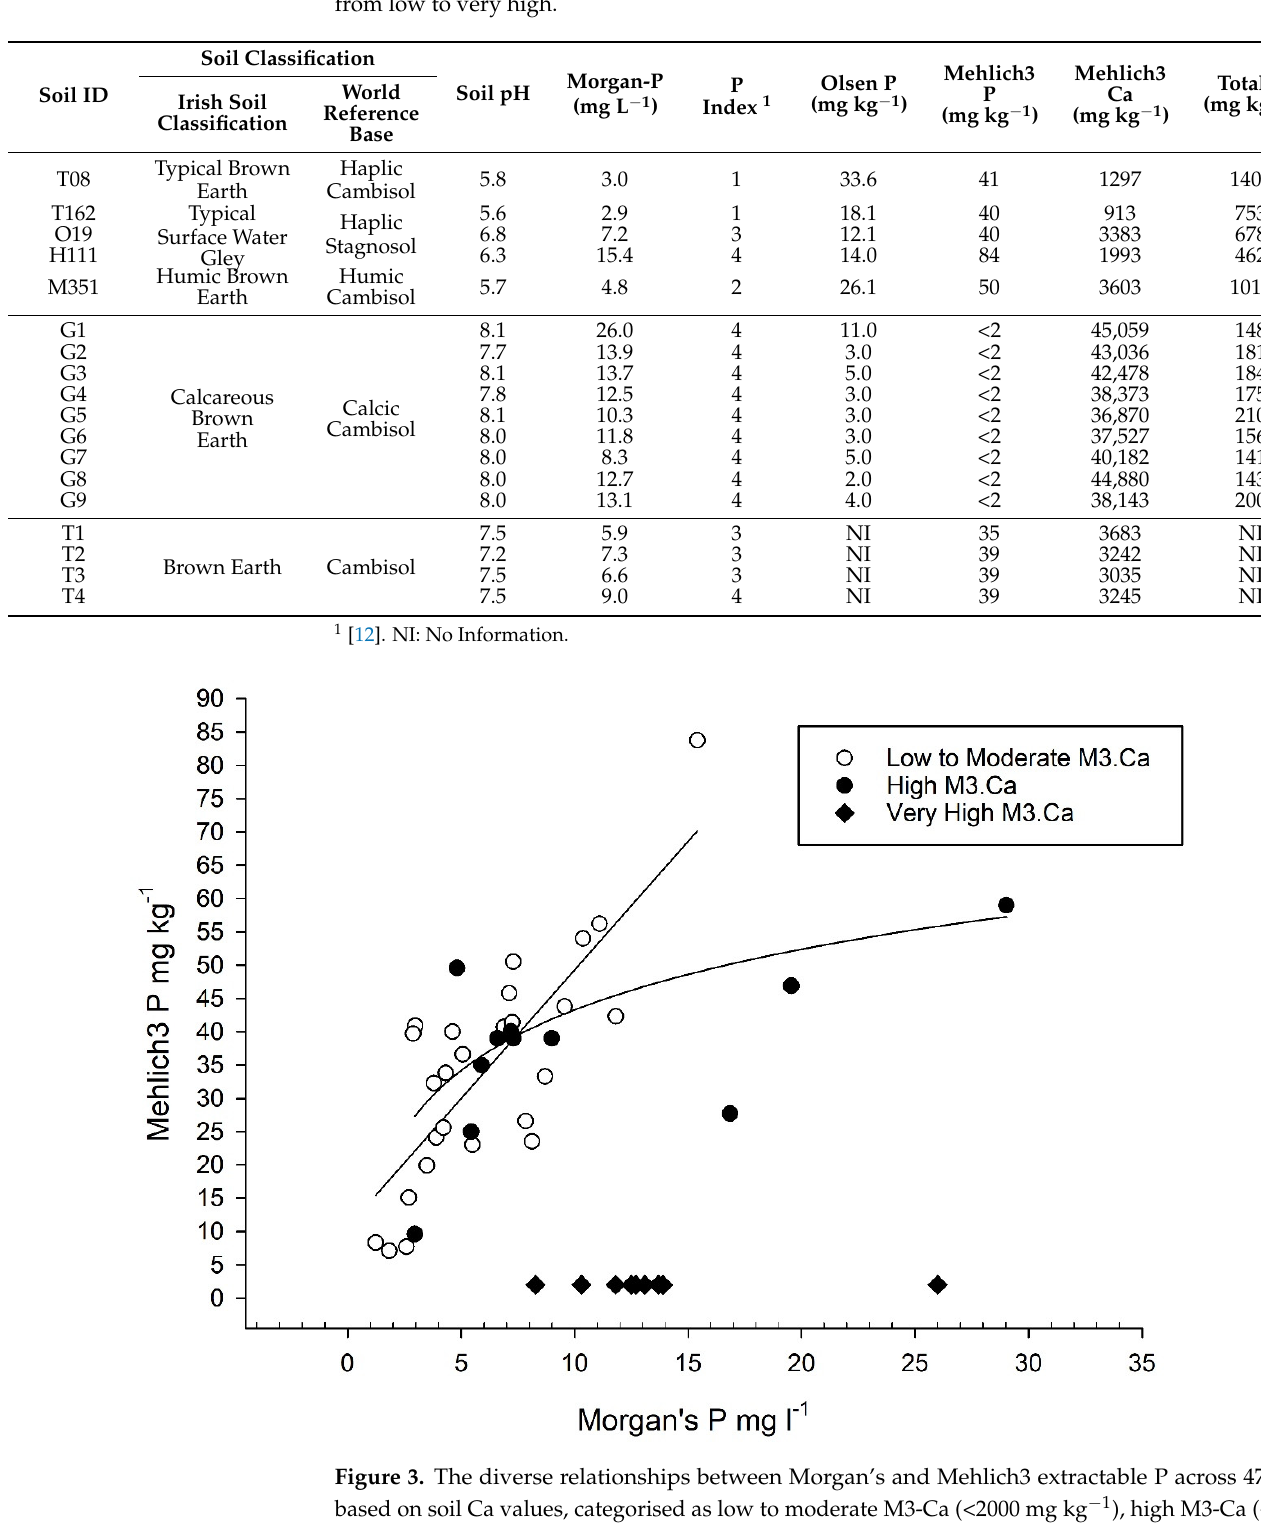
Table 4. Soil type and chemical properties of the 18 case-study soils with a wide range of Ca values from low to very high.